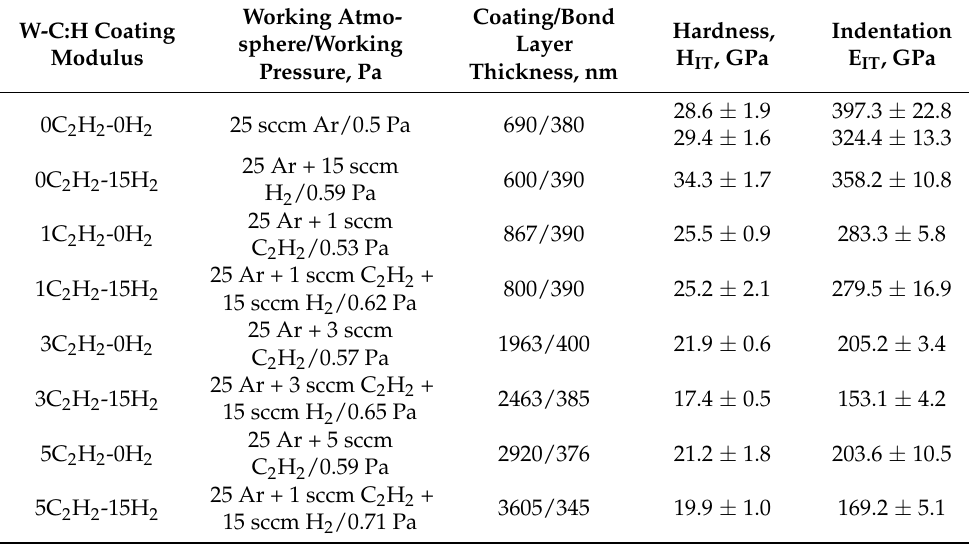
Table 1. Deposition conditions and mechanical properties of the studied HiPIMS W-C(:H) coatings on steel